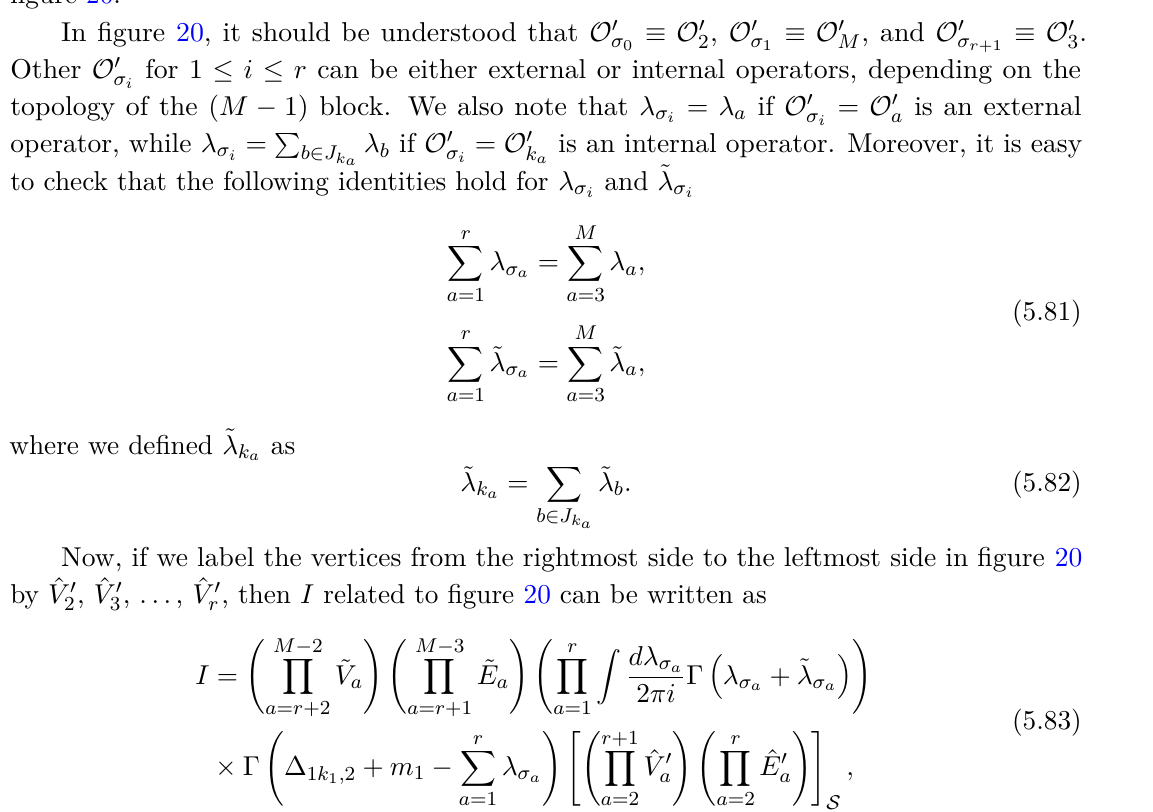
2 , σ , and σ 3 . Other O 0 can be 0 ≡ 1 ≡ M r +1 ≡ σ a